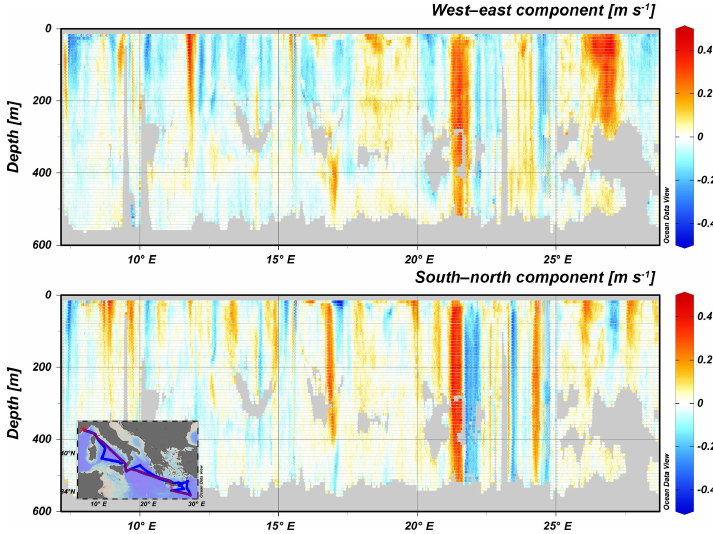
Figure 3. Velocity distribution of the upper water column along a west–east section through the Mediterranean Sea. Data are recorded by SADCP. Inner panel indicates the location of the ship track and the section. Grey areas: no data are